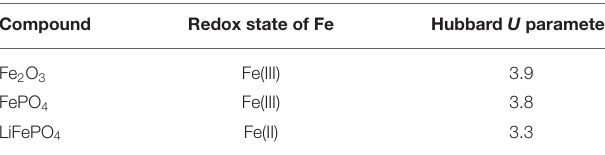
TABLE 2 | The computed and measured lattice parameters of Fe 2 O 3 , FePO 4 , LiFePO 4 and cubic zirconia